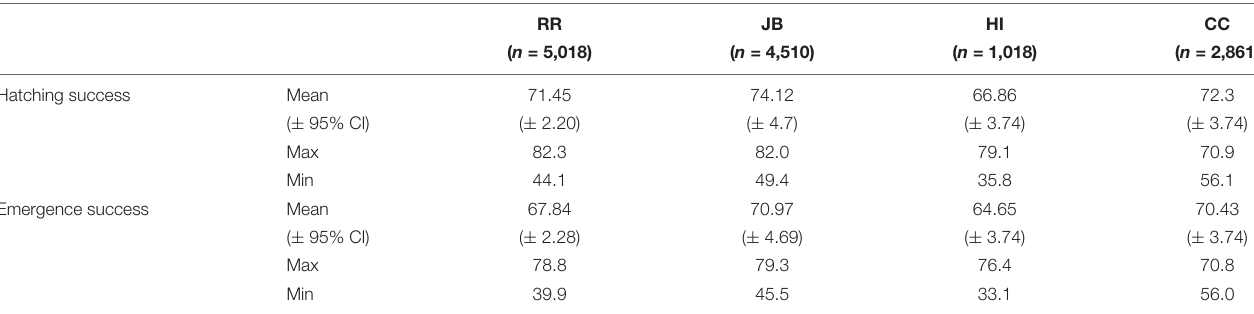
TABLE 1 | Descriptive statistics for nest success that were made available for